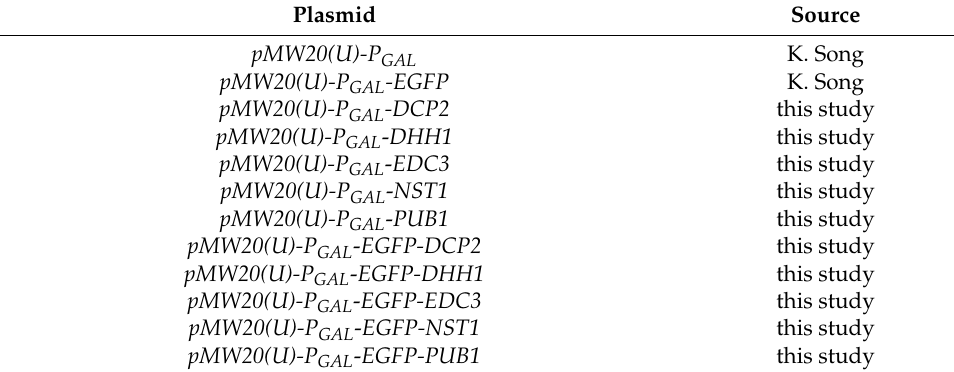
Table 2. List of the plasmids used in this